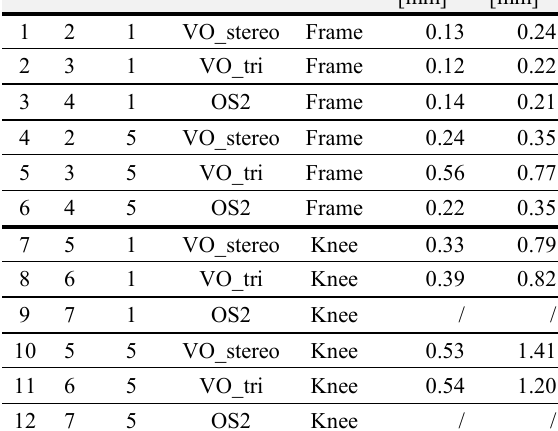
Table 3. Mean and maximum Euclidean distances of corresponding points of oriented point clouds. RMS and Max are calculated using three transformed point clouds at